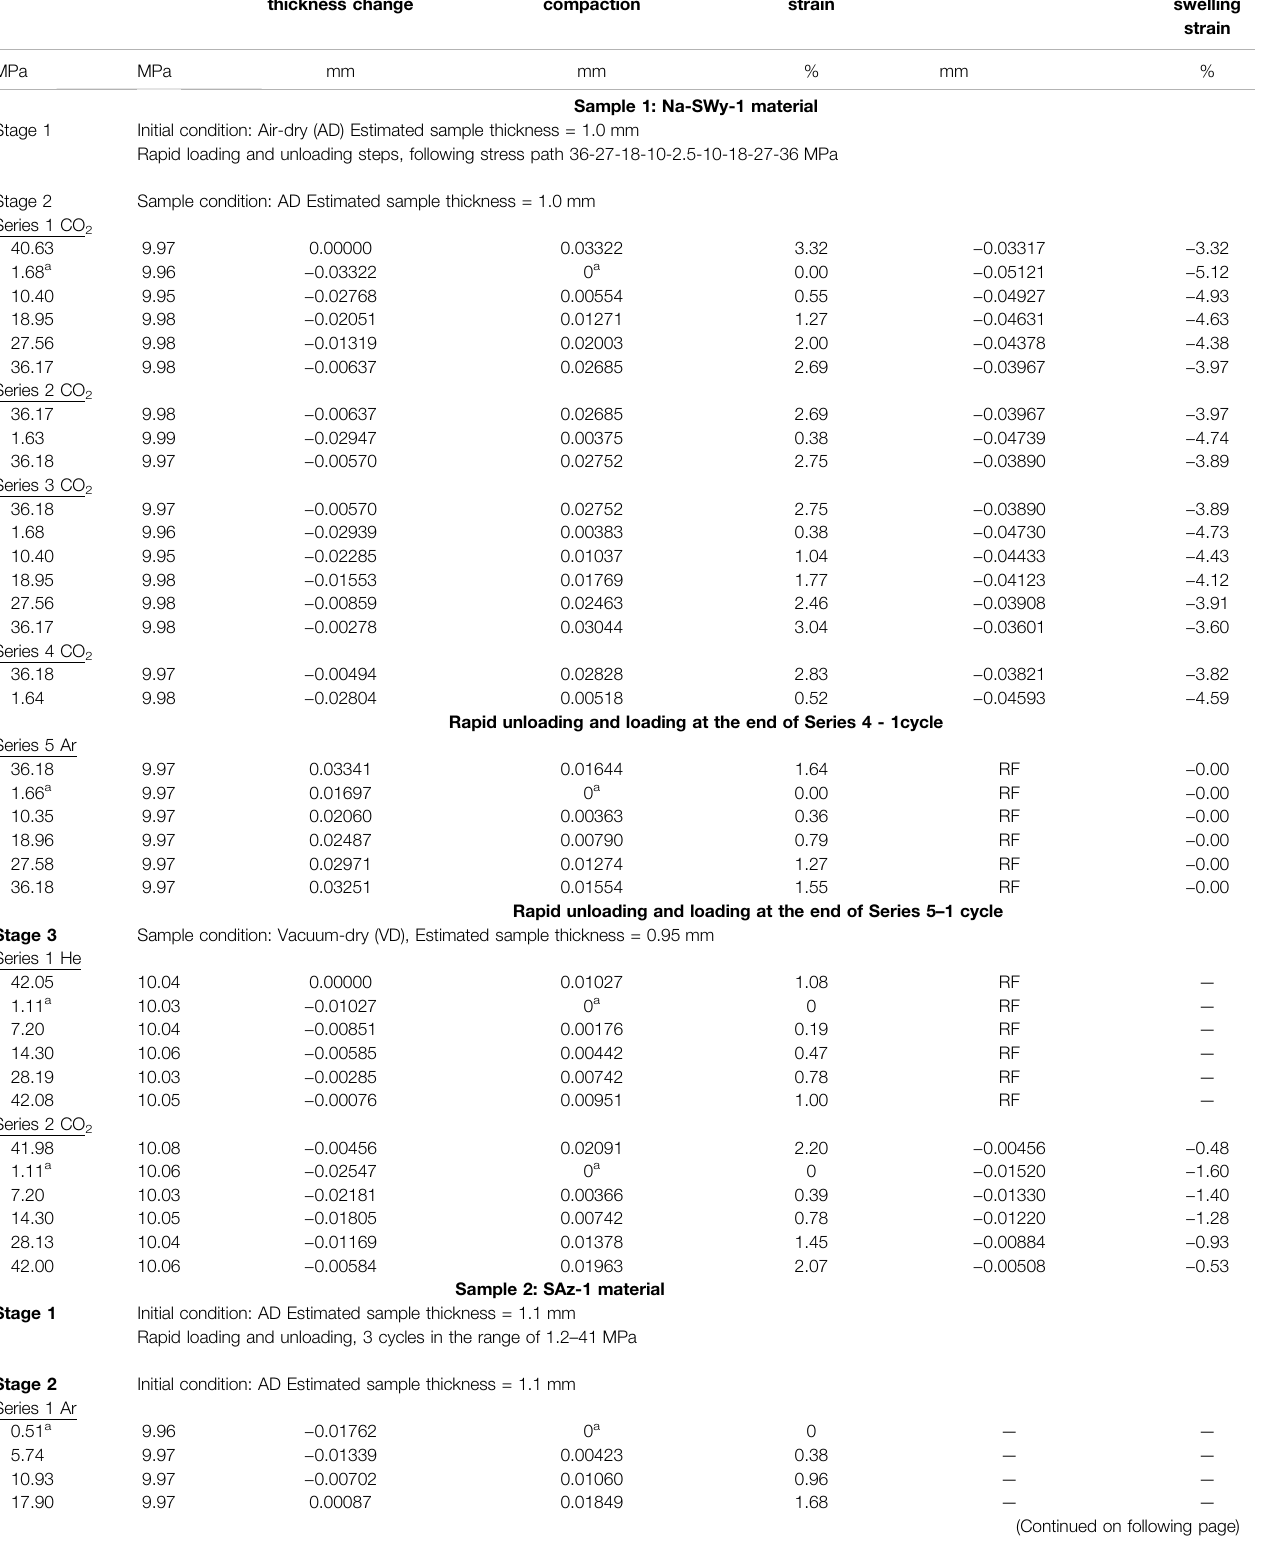
TABLE 1 | Summary of experiments, experimental conditions and key data obtained. σ e P f